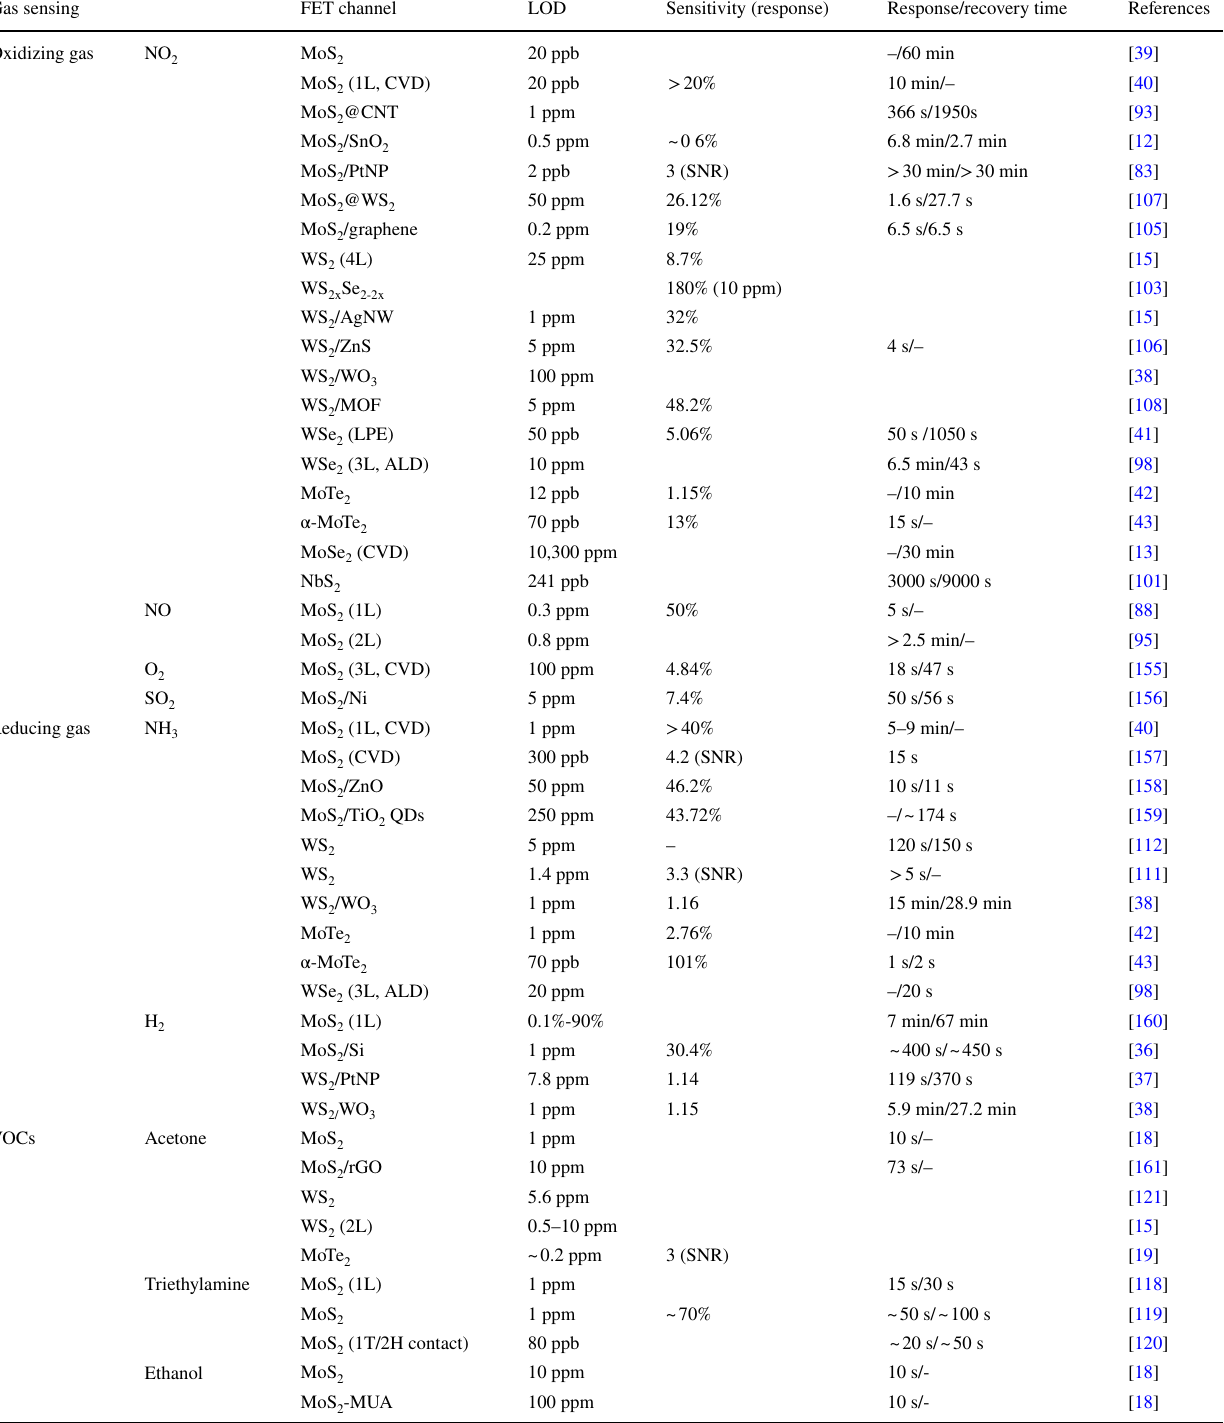
Table 1 Gas sensing with 2D TMDC-based FET sensors: device structure and sensing performance